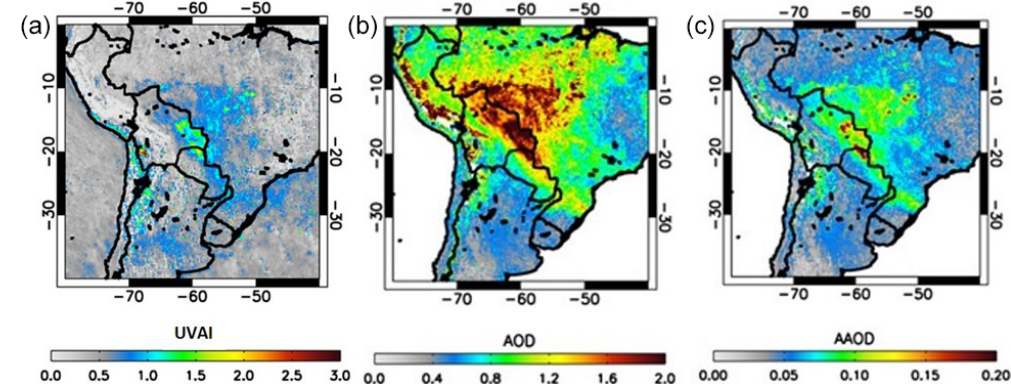
Figure 10. September 2019 monthly average values of TROPOMI UVAI (a) , 388nm AOD (b) , and AAOD (c) over South America.